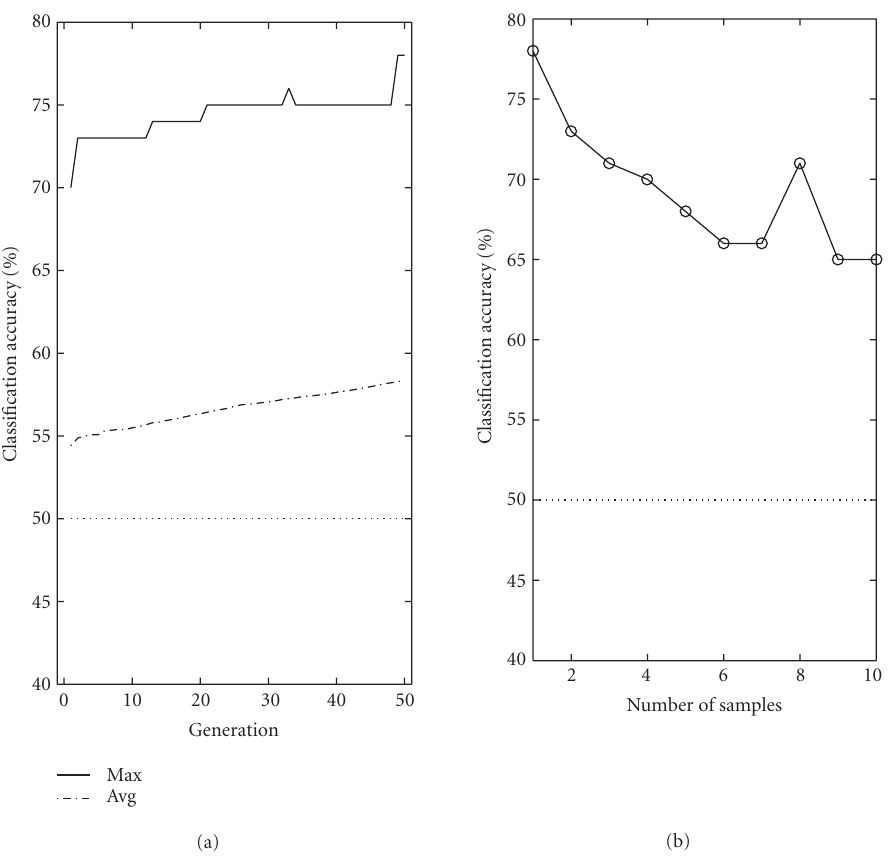
Figure 3: Feature subset evolution and overfitting. (a) Mean fitness of all individuals in the cumulative population as of that generation; “avg” is the average and “max” the maximum mean fitness. Data shown is for subject 6, Infomax transformation. Note that the maximum mean fitness in the cumulative population does not monotonically increase because repeated sampling of a particularly fit individual may reduce that individual’s mean fitness value (see (b)). (b) Mean fitness of the best individual in the population for each of several di ff erent “sampling” values. Each “sample” is the mean classification accuracy from a full 10-fold cross-validation run, which uses 10 randomly selected train/test partitions of the trials for that subject. The generally decreasing function reflects overfitting at the feature selection level, whereby so many feature subset evaluations occur that the system finds train/test partitions of the trials that lead to higher-than-average fitness for a specific feature subset. Additional sampling of how well that feature subset classifies the data increases confidence that the oversampled result is not simply due to 10 fortuitous partitions of the